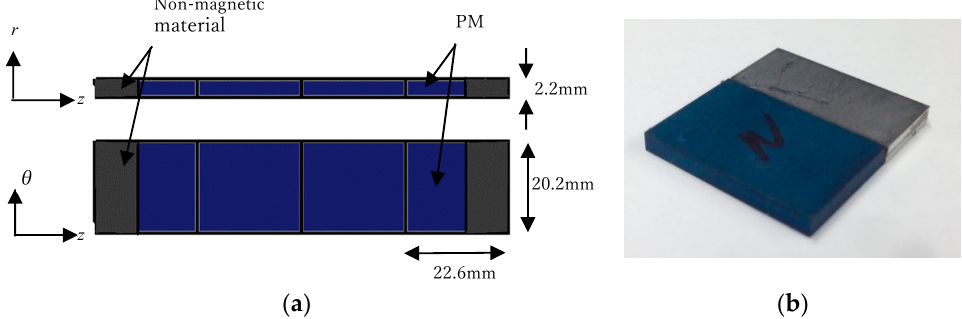
Figure 3. PMs for axial demagnetization: ( a ) magnet configuration; ( b ) photograph of magnet.